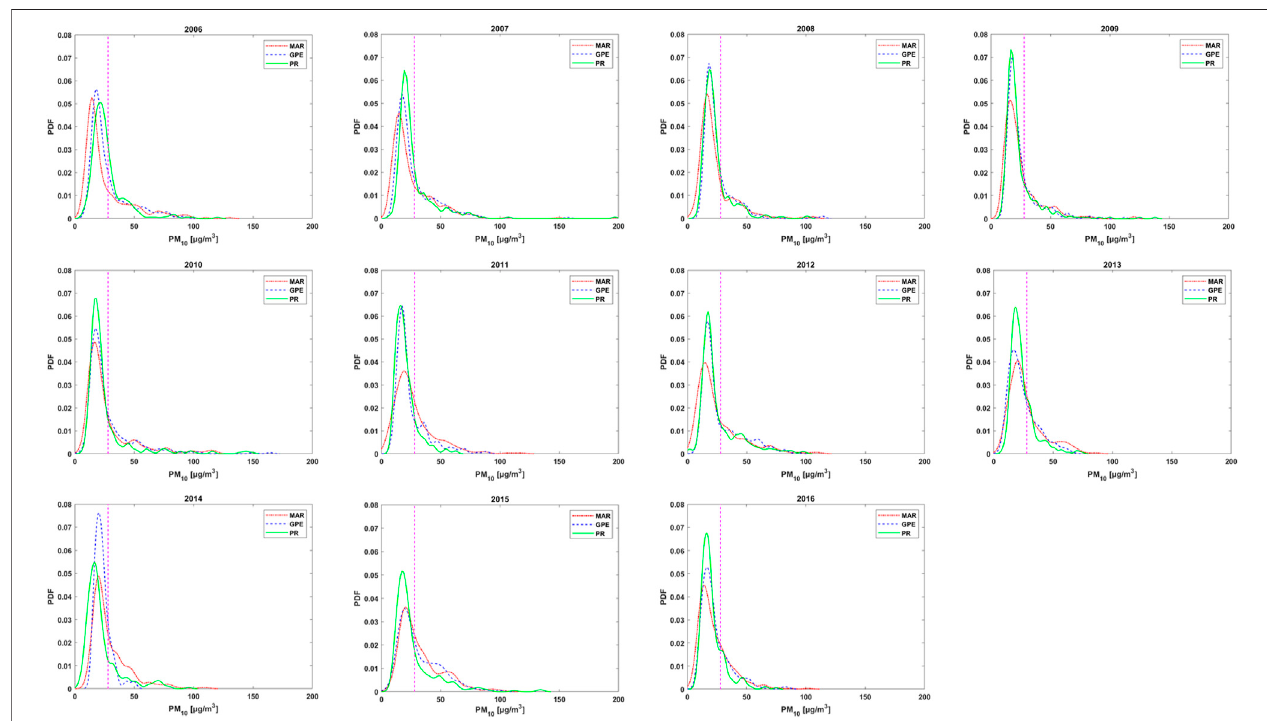
FIGURE 5 | Probability Density Function (PDF) of PM 10 concentrations at Martinique (MAR), Guadeloupe (GPE) and Puerto-Rico (PR) by year from 2006 to 2016. The vertical purple dashed line shows the African dust detection threshold estimated at 28 μ g/m 3 over 11 years.